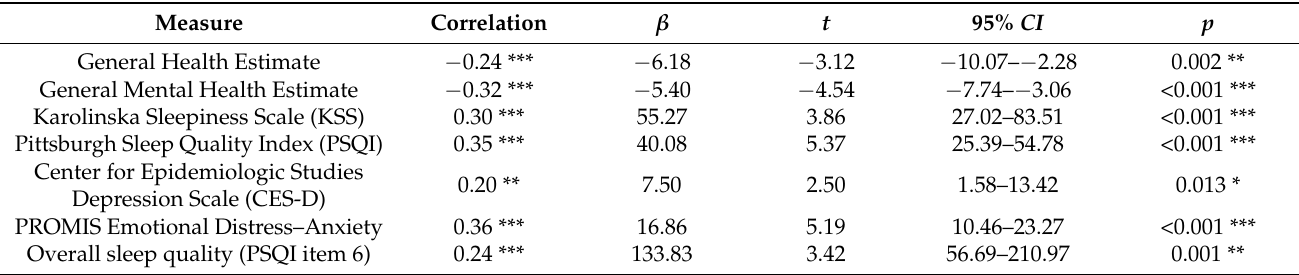
Table 3. Self-report measures as predictors for sleep